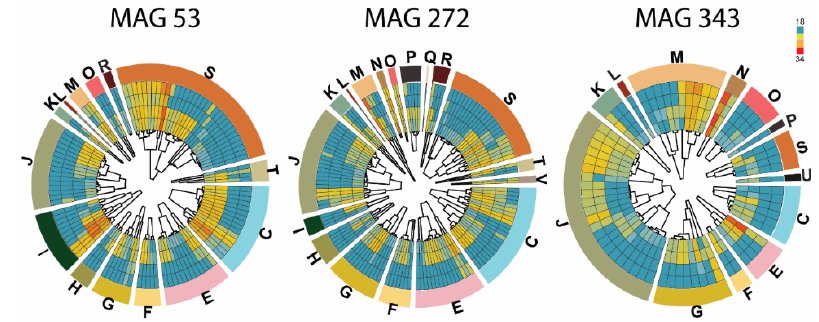
Figure 3. The proteome of EVs isolated from fecal inoculum cultivated in vitro for 24 h. The inner part of the circles displays a dendrogram and a heatmap of the identified proteins within EVs from MAG 53, 272, and 343 when grown with no carbohydrate (two outer rings) or with mannan (two inner rings). The colors in the heatmap indicate protein abundance and range from low abundance (blue; log2(LFQ) of 18 or lower) to high (red; log2(LFQ) of 34). The outer part of the circle shows Clusters of Orthologous Groups (COG) of proteins represented as one-letter-codes that are described below. Information storage and processing; [J] Translation, ribosome structure and biogenesis, [A] RNA processing and modification, [K] Transcription, [L] Replication, recombination and repair, [B]